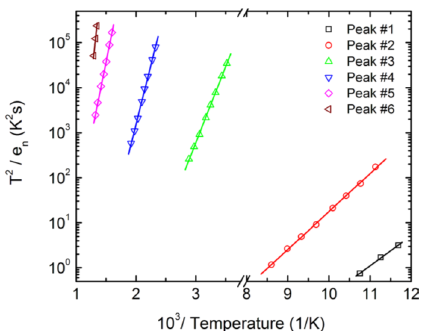
80–800 K. ( b ) 80–800 K.